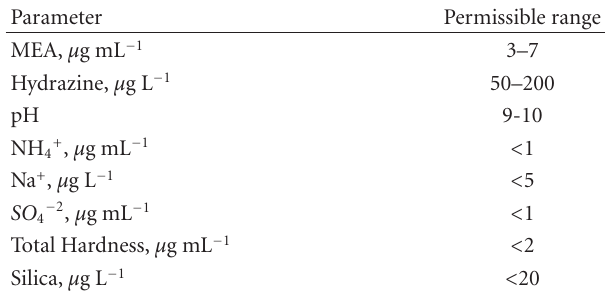
Table 2: Typical water chemistry specifications in the secondary cycle of steam-generating systems: MEA, hydrazine and ionic impurities.